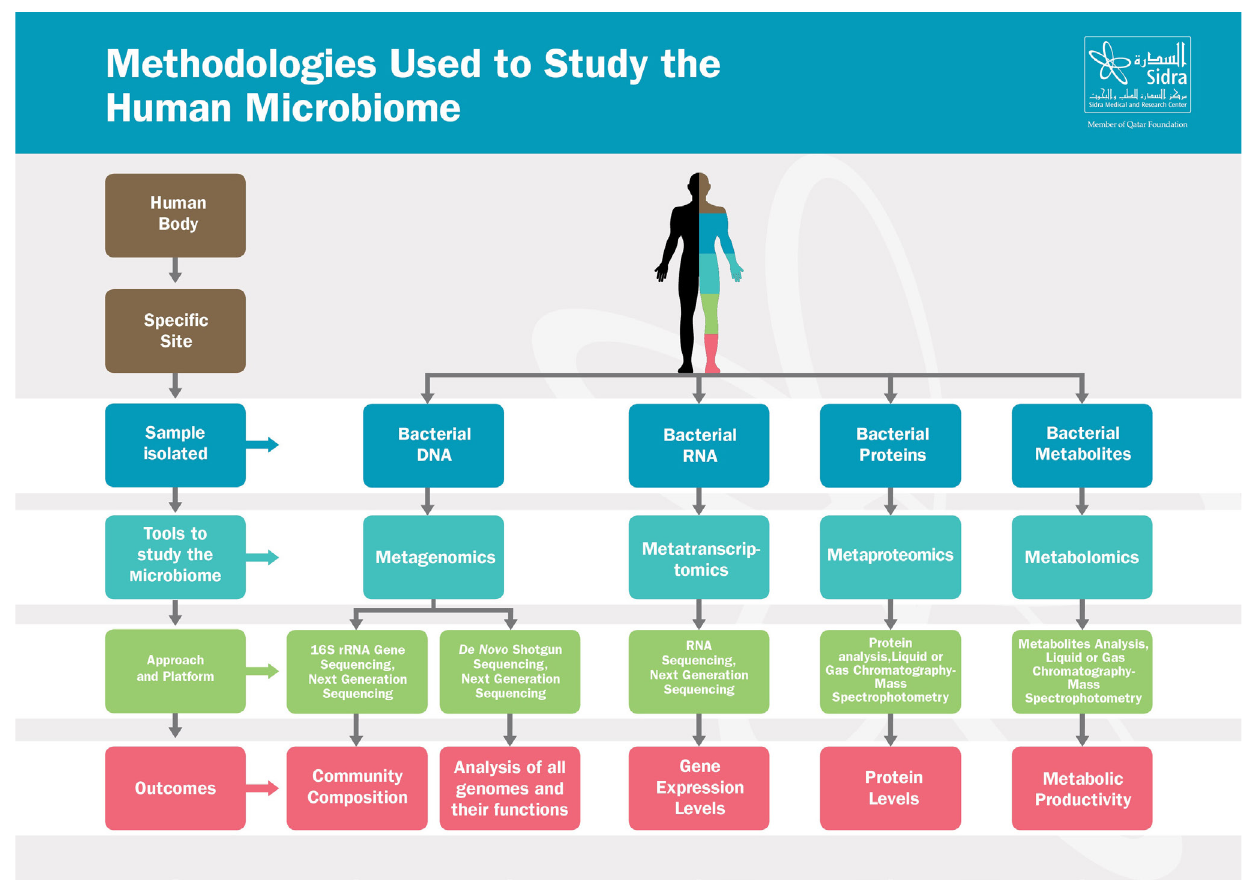
FiGURe 1 | Methodologies used to study the human microbiome. The human body harbors large amounts of microbes that vary from one site to another. From each specific site, microbes can be studied in various ways depending on the samples isolated. Those tools range from metagenomics, metatranscriptomics to metaproteomics and metabolomics. Based on the approach and platform used, results include composition of the microbial communities, microbial genes function, gene expression or proteins levels, and metabolites